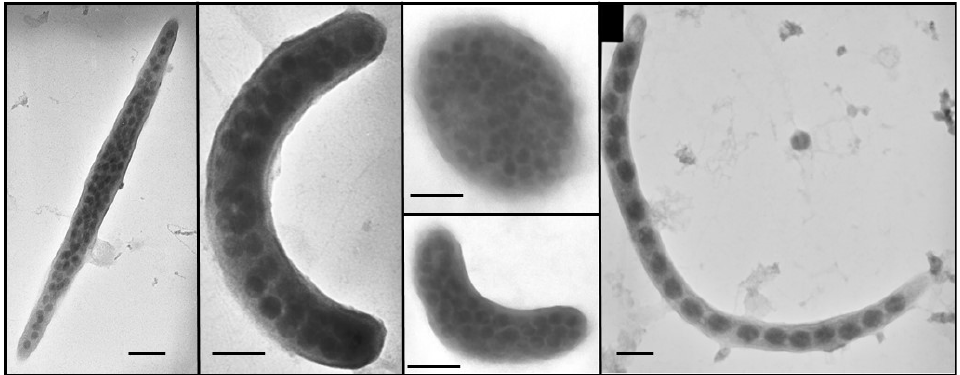
Figure 4. Electron micrographs of viral infected bacterial cells containing mature phage particles. Scale bar = 100nm.